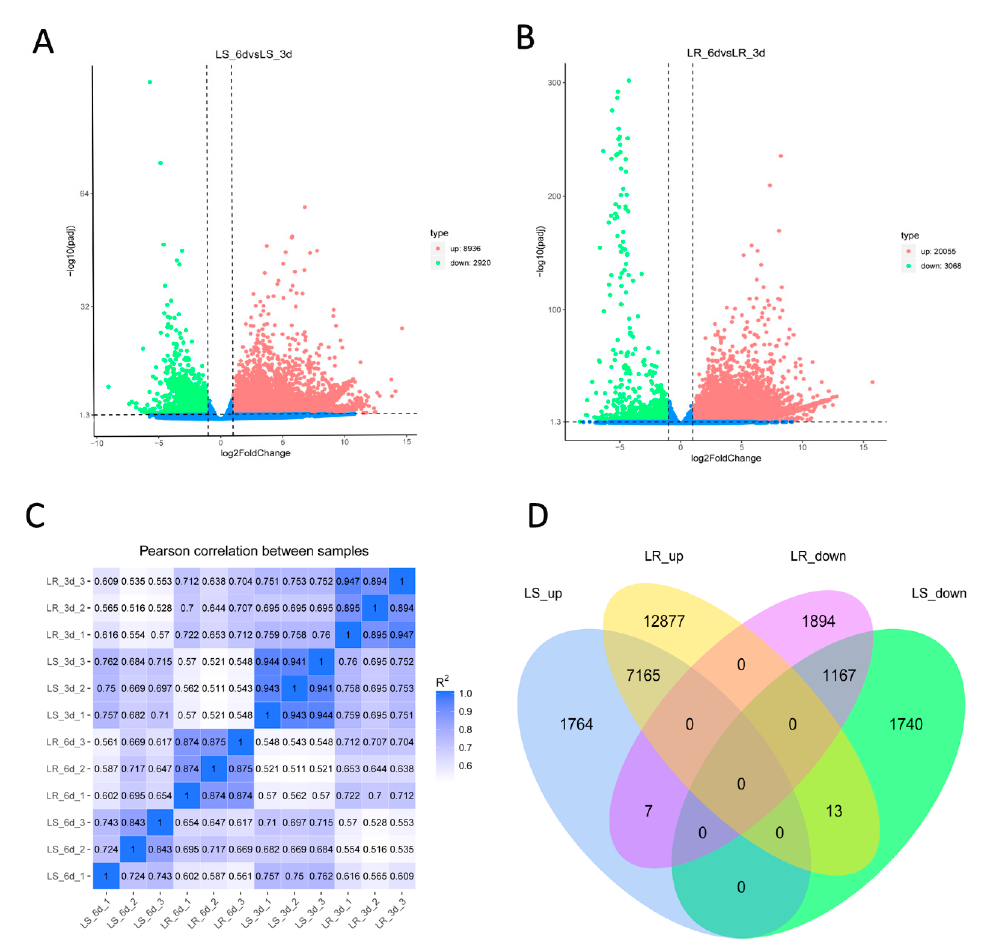
Figure 3. Analysis of differentially expressed genes (DEGs) in LS comparison setting (LS_6d vs. LS_3d) and LR comparison setting (LR_6d vs. LR_3d). The volcano plot of DEGs in LS ( A ) and LR ( B ). Green dots represent the significantly downregulated DEGs. Red dots represent the significantly upregulated DEGs (padj < 0.05). ( C ) Correlation cluster between three biological replicates of LS_3d, LS_6d, LR_3d, and LR_6d. ( D ) Venn diagram of upregulated and downregulated DEGs in LS and LR comparison settings. LS_up: upregulated DEGs in LS; LR_up: upregulated DEGs in LR; LS_down: downregulated DEGs in LS; LR_down: downregulated DEGs in LR.